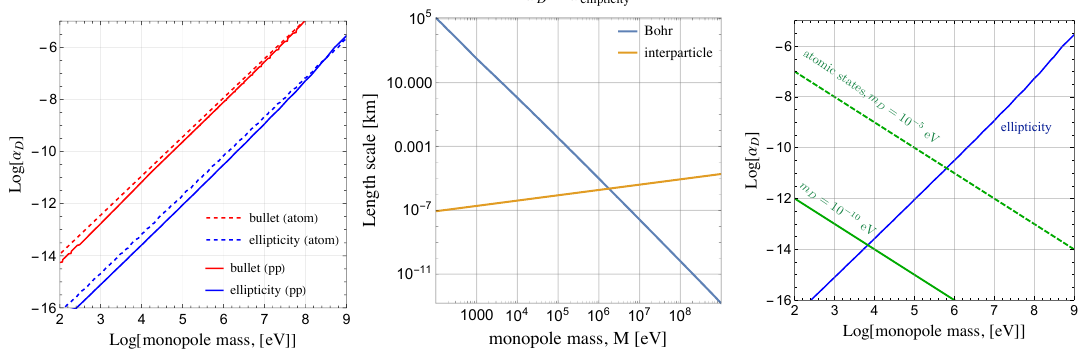
Figure 3 . In the left panel we show the resulting ellipticity and bullet cluster bounds on the dark fine structure constant from DM self-scattering in the cases of atomic (eq. (2.6)) or p − p scattering (eq. (2.12)). In the middle panel , we show the Bohr and interparticle lengths at the dark coupling which saturates the strongest bound in the left panel. Lastly in the right panel , we compare the ellipticity bounds to the requirement that monopoles occupy atomic states (eq. (2.2)) for two representative choices of dark photon